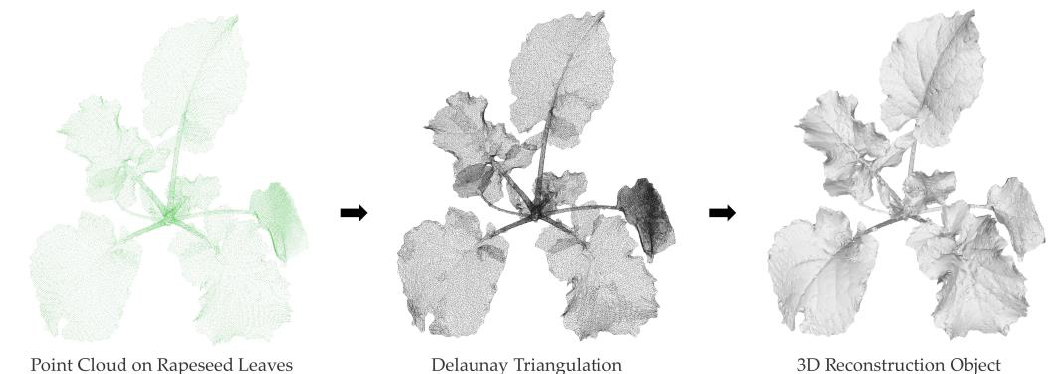
Figure 6. Schematic diagram of 3D reconstruction of point cloud Delaunay of single rapeseed in experimental data.